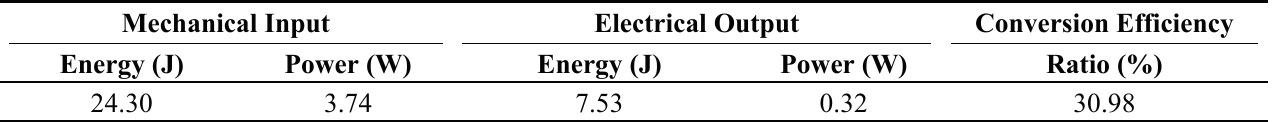
Table 5. The input, output, and conversion